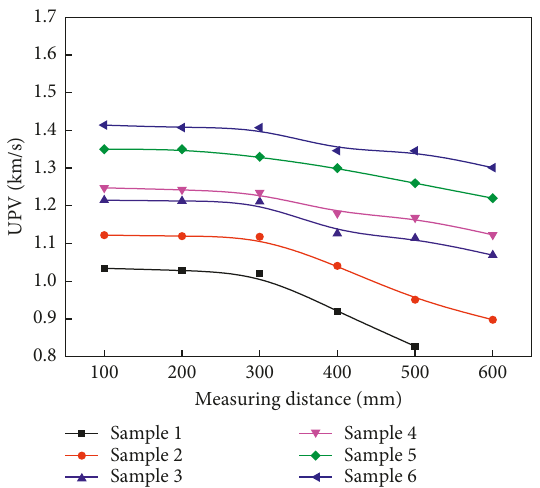
Figure 9: Variation of UPV with measuring distance. Figure 10: Variation of UPA with measuring